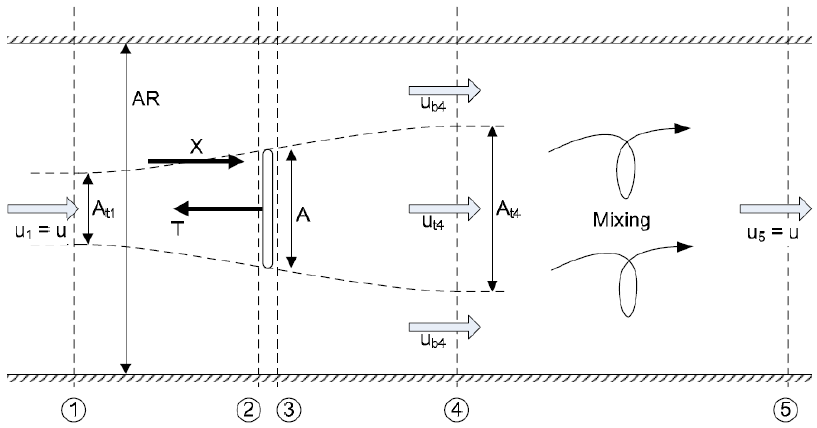
Figure 2. Linear momentum actuator disc model (ADM) in a parallel ‐ sided channel (adapted from [28]).